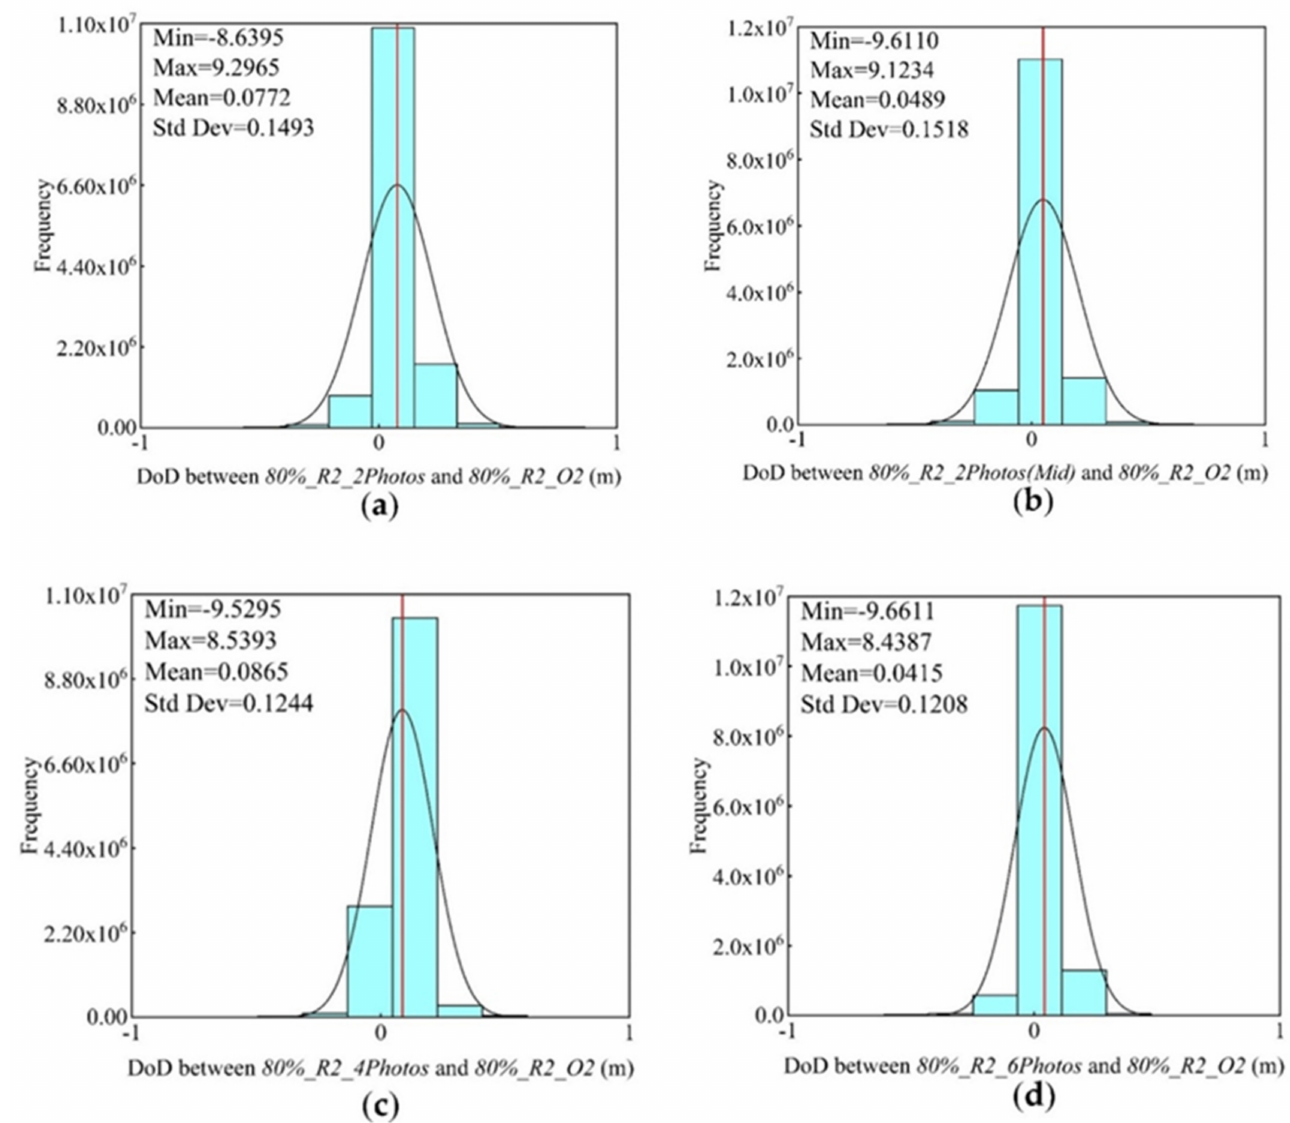
Figure 8. DoD results of different oblique imaging numbers and location schemes. Histogram ( a ) represents the result of 2 images in the end of the oblique flight route, histogram ( b ) represents the result of 2 images in the middle of the oblique flight route, histogram ( c ) represents the result of 4 images at equal intervals of the oblique flight route, histogram ( d ) represents the result of 6 consecutive images in the middle of the oblique flight